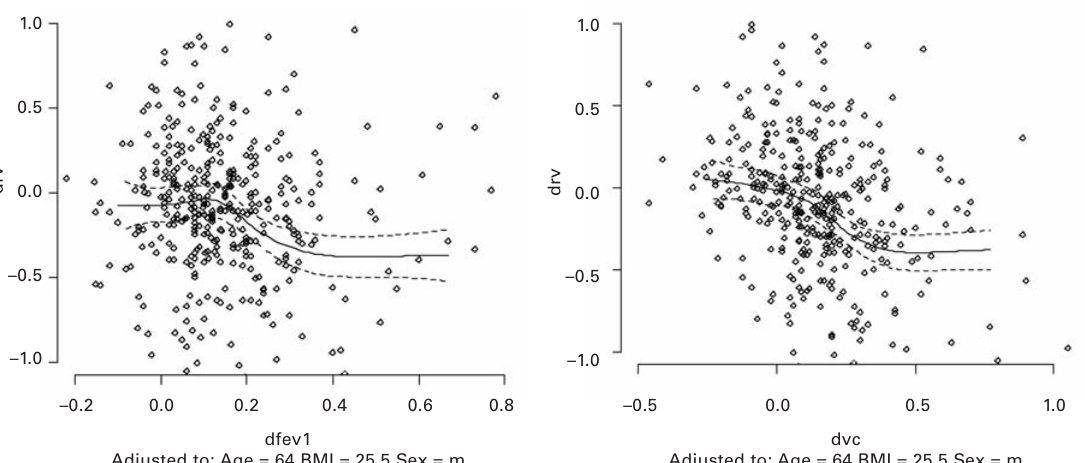
Figure 2 Adjusted multiple linear regression model showing a non-linear relationship between Δ VC compared to Δ RV after bronchodilation. d: difference in the value of the respective parameter before and after bronchodilation; RV: Residual volume in litres,